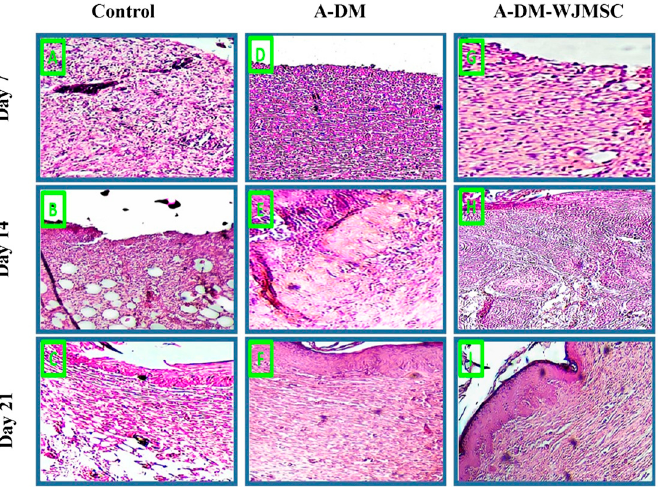
Figure 6. Histological evaluation of skin biopsies using H&E staining for control (untreated), FADM, and FADM-WJ-MSC groups at 7, 14, and 21 days after implantation. The images ( A – C ), ( D – F ), and ( G – I ) are control, FADM, and FADM-WJ-MSCs groups during 21 days, respectively (scale bars = 100 µm, 10×; insets: 200 µm, 20×).